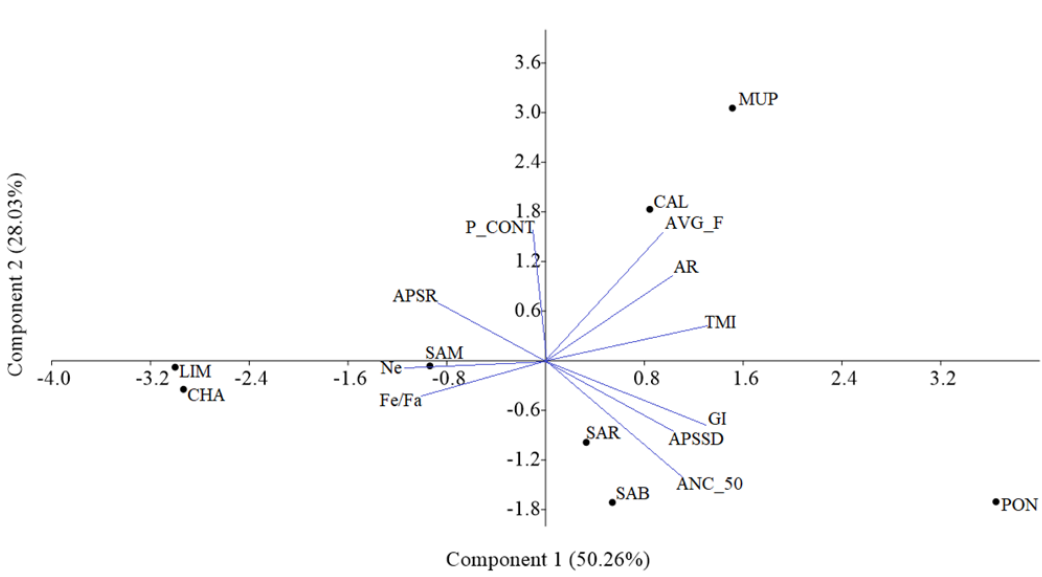
Figure 3. Biplot of the first two principal components. Principal component analysis (PCA) performed on the following population parameters: true mean inbreeding (TMI); average coefficient inbreeding (AVG_F); average relatedness (AR); effective population size ( Ne ); effective number of founders/effective number of ancestors ( fe / fa ); ancestors explaining 50% (ANC_50); pedigree content (P_CONT); population size expressed as average ratio throughout the years (APSR); population size expressed as average standard deviation throughout the years (APSSD); generation interval (GI). The vectors represent the variables and the points represent the breeds.